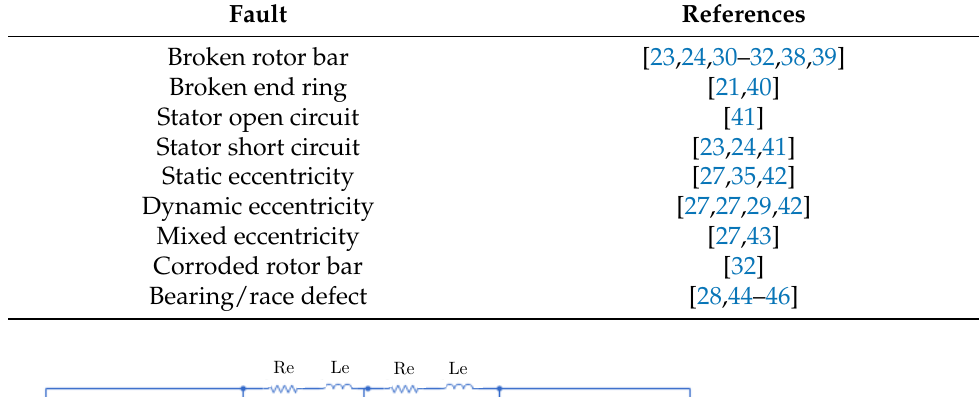
Table 1. MCC reference for different types of faults.